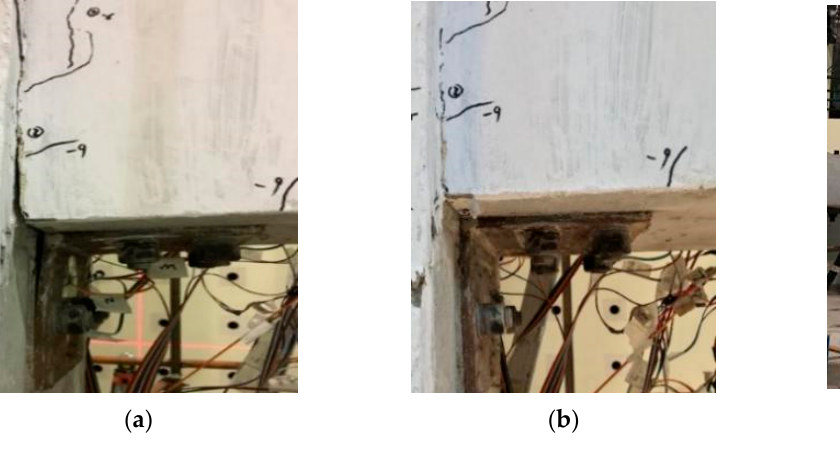
Figure 9. Crack pattern and failure mode of the HPC connection: ( a ) opening of crack; ( b ) closure of crack; ( c ) failure